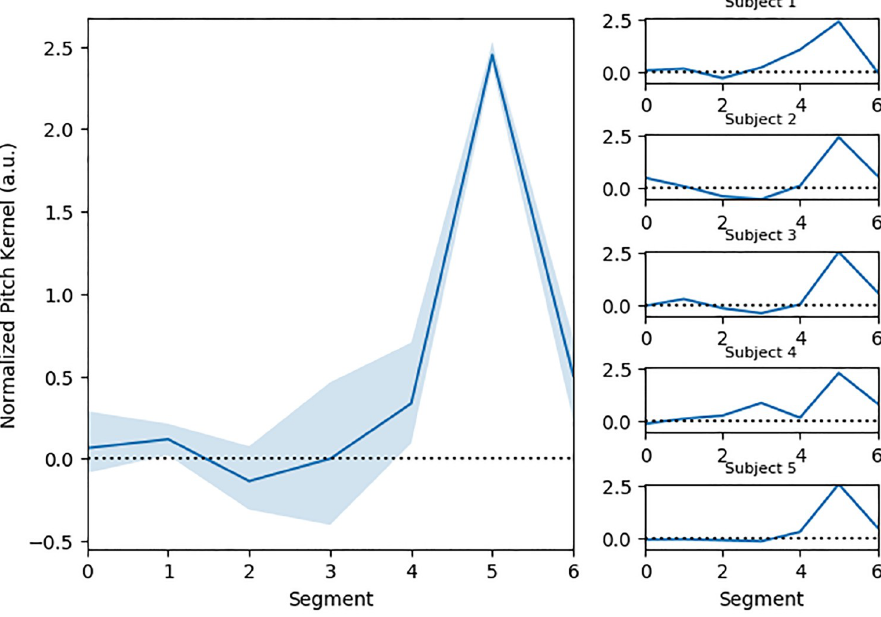
Fig 4. Mental representation of interrogative prosody. Left: Average first-order kernel derived by reverse-correlation on N = 5 participants, showing an increase of pitch at the end of the second syllable. Right: individual kernel from each of the